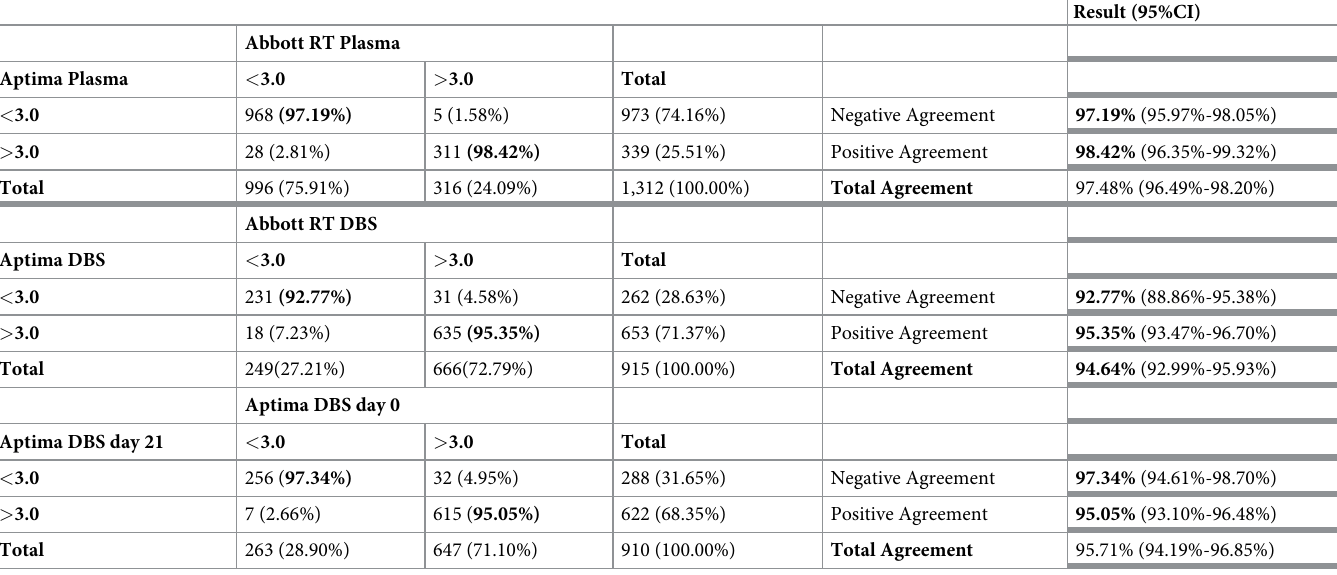
Table 1. Agreement between Aptima and Abbott RT VL assay at a clinical cut-off of 3 log copies/mL (1,000 copies/mL) of HIV for the various sample types.